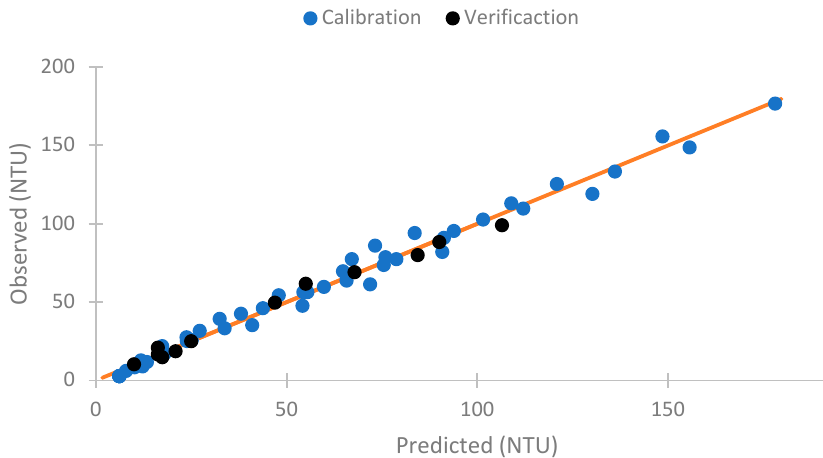
0.00.51.01.52.0